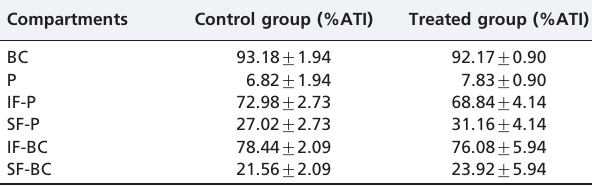
Table I - The effect of the senna extract on the 99m Tc distribution for each blood